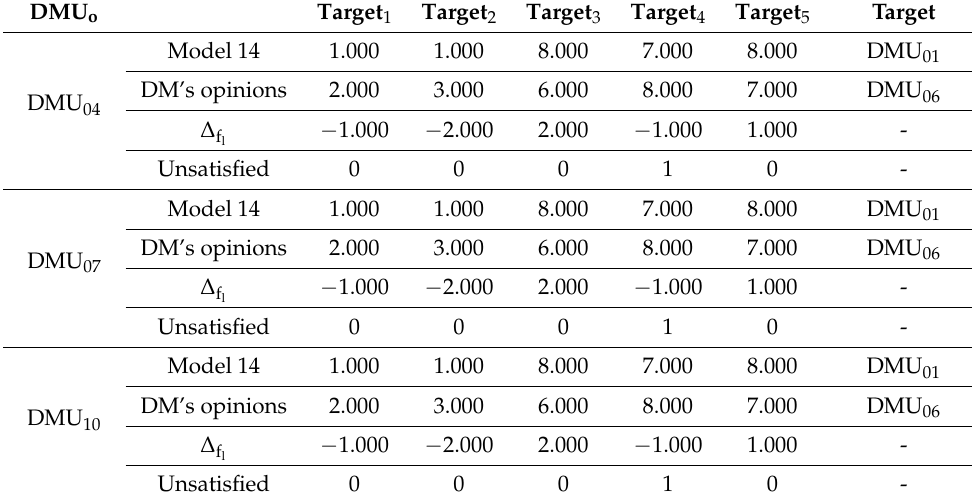
Table A4. The results of solving model 14 (Step 1 of STEM for p = 1) and DM’s opinions about them for three DMUs in the second case study.